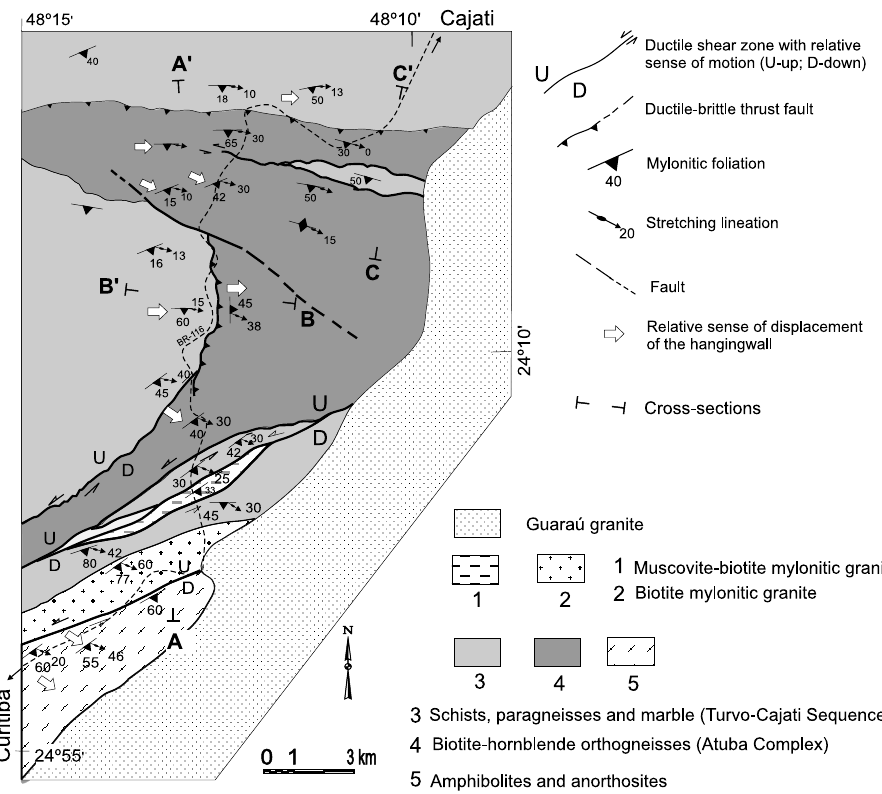
Fig. 2 – Geological map showing the distribution of main lithostructural units in the Cajati region (modified from Dehler et al. 2000). For localization see map and caption of Figure 1B.